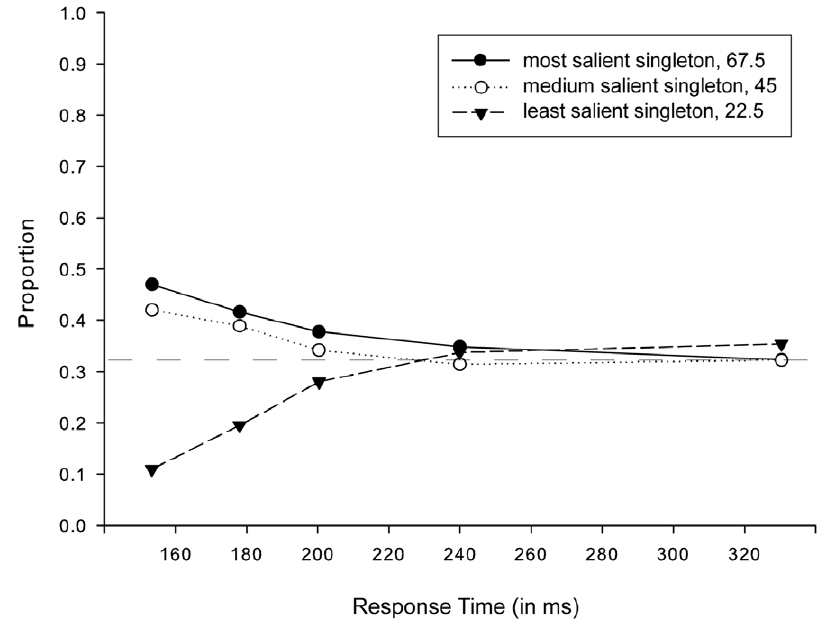
Figure 4. Salience-driven selection in initial saccades in Experiment 2. Proportions of initial saccades directed towards each of the three singletons (22.5 u , 45 u and 67.5 u ), separately for each bin of the response time distribution and irrespective of target identity.